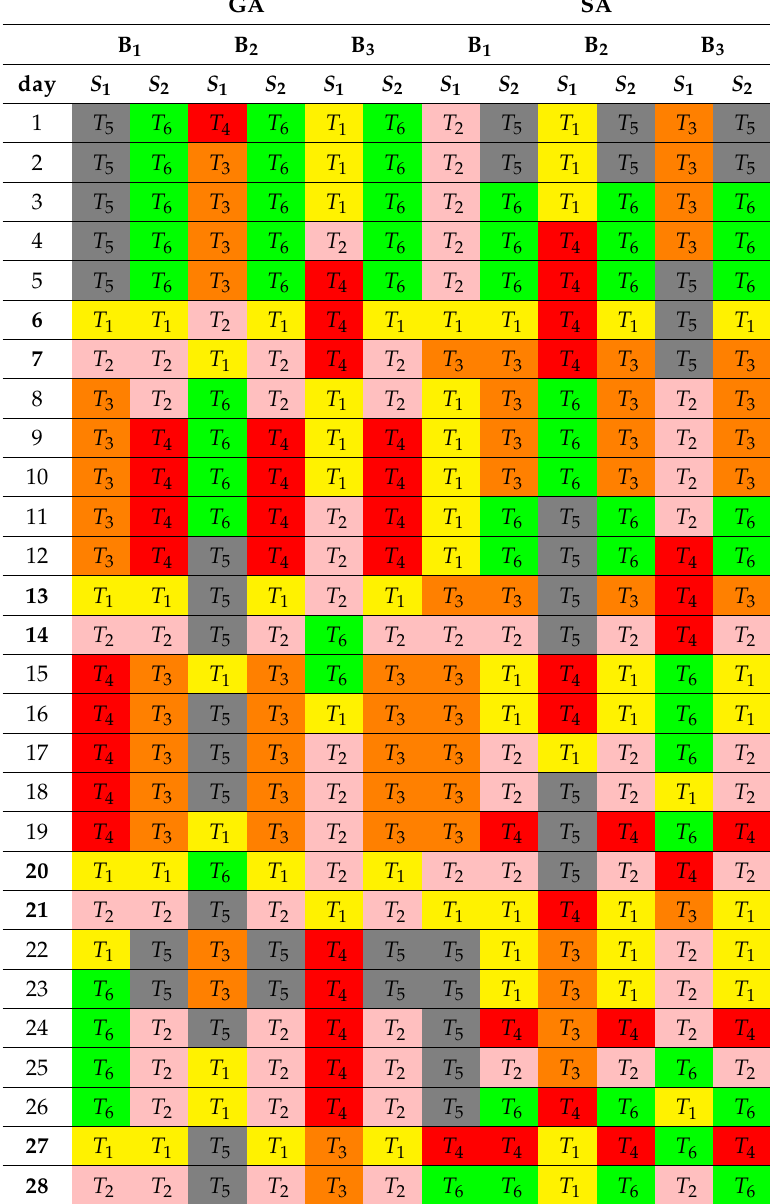
Table 9. Genetic Algorithm (GA) and Simulated Annealing (SA) physician schedule for September. GA